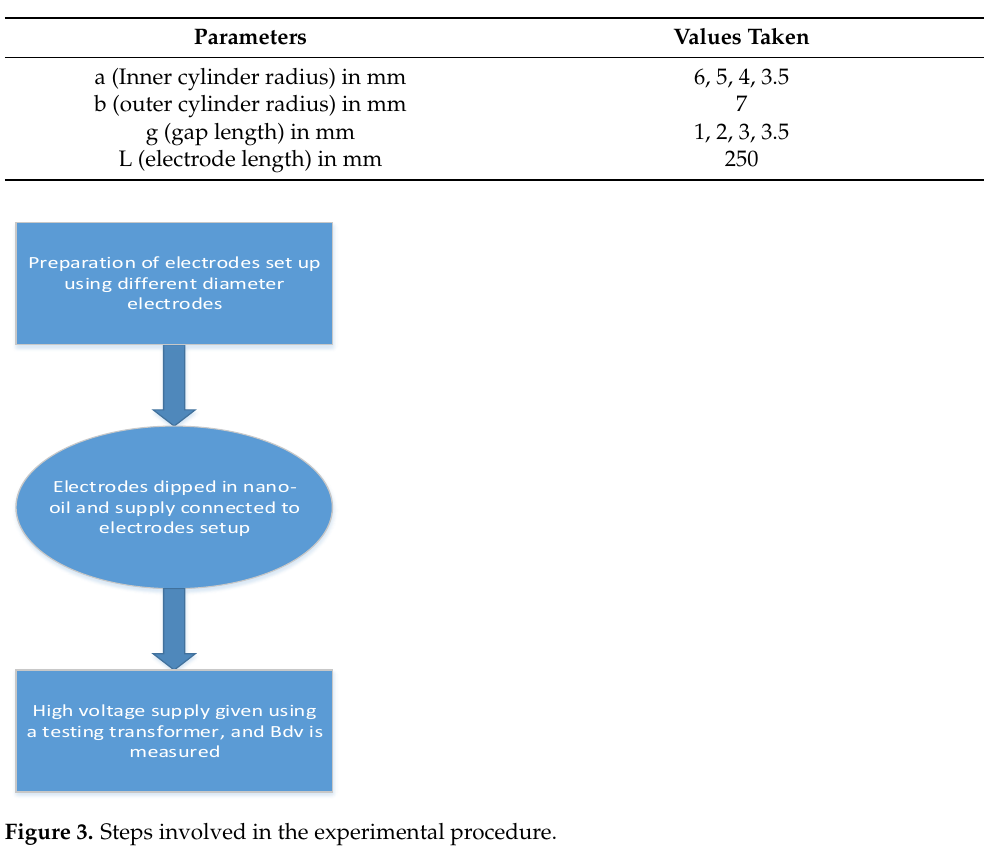
Table 4. Specifications of Electrodes.